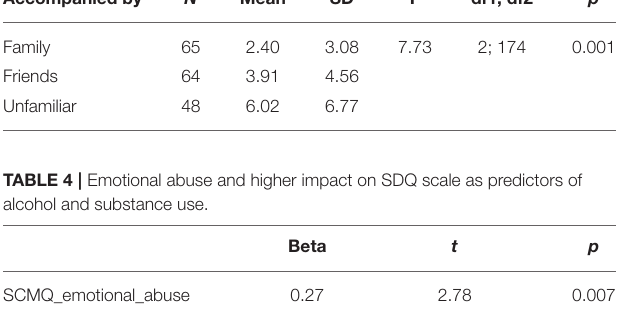
TABLE 3 | Significance of differences according to who accompanied the child on AADIS A scale. Accompanied by